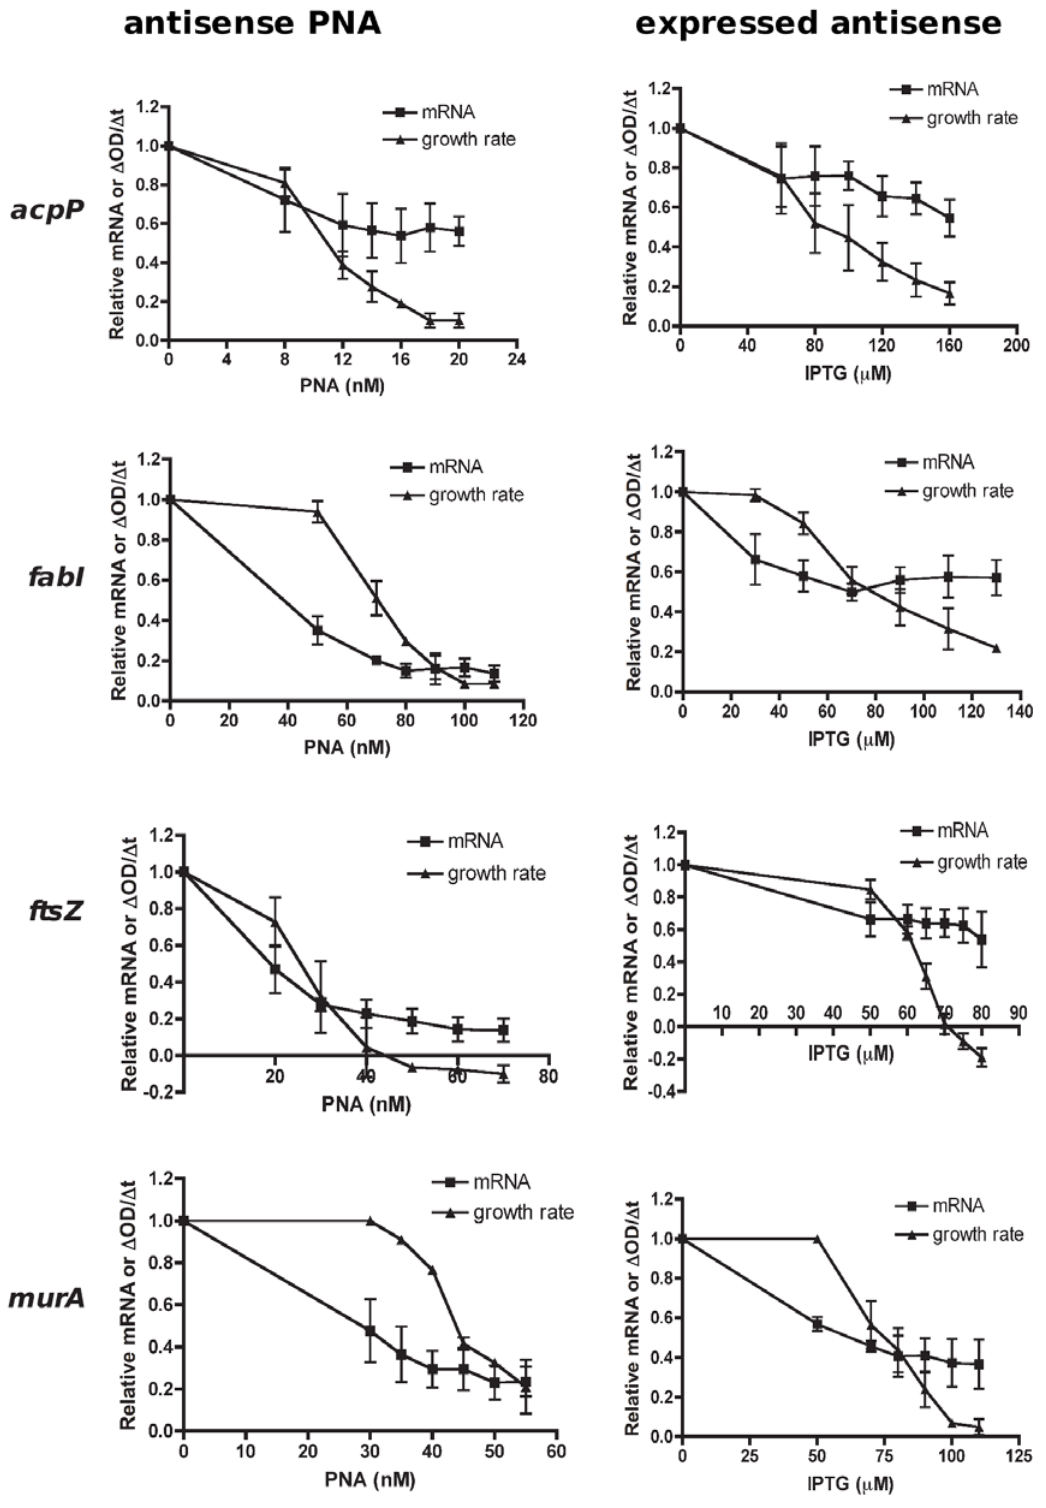
Figure 3. Gene silencing in E.coli to obtain a titration of declining growth rates and transcript levels by antisense PNA and expressed antisense. E. coli AS19 was treated with PNA doses, while TOP10 clones containing antisense-expressing plasmids were induced with various IPTG concentrations as shown in Figure 2, so as to obtain growth inhibition in a dose-dependent manner. Total RNA from E. coli cultures was harvested at the time when the control culture increased in OD 550 by 0.1. RNA was used for cDNA synthesis and quantitative real-time PCR to determine mRNA levels by normalization to a reference gene rpoA , and then calculated relative to the unsilenced (untreated) control. Growth rates were determined by OD 550 readings over time. The relationship between mRNA and growth rate decline indicated growth requirement stringency of each gene.